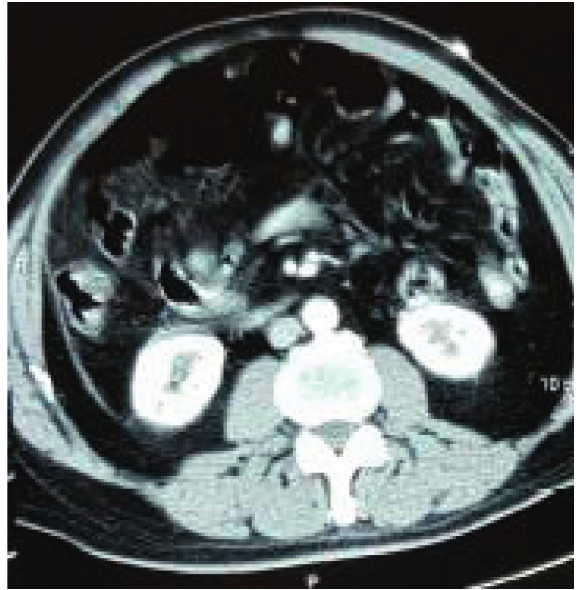
Figure 2: Abdominal CT scan: nonconclusive